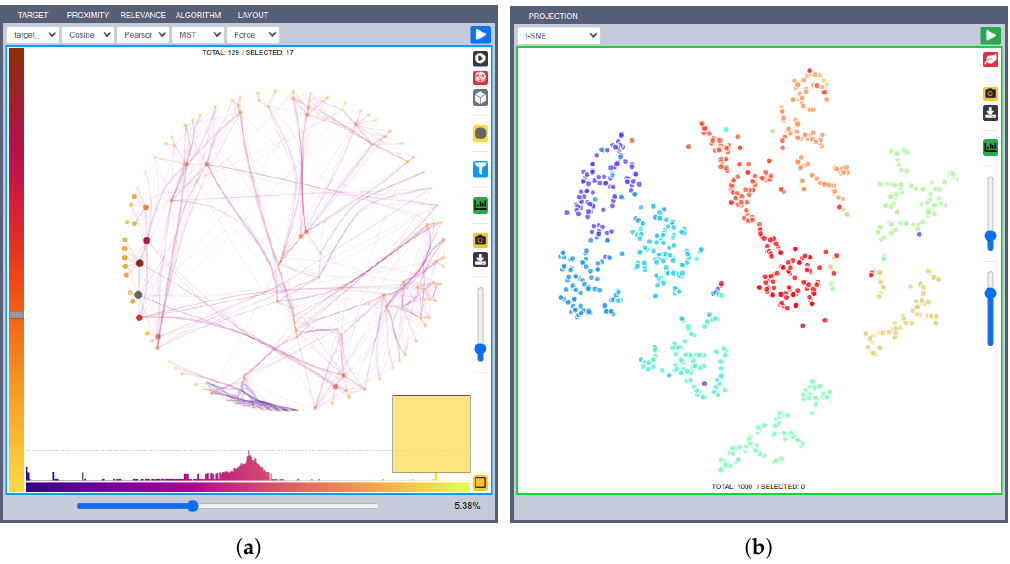
Figure 2. GFF main window and its two panels. The left panel ( a ) exhibits a minimum spanning tree for a dataset with 129 features. At the top the display construction parameters may be selected. The bar at the left enables selecting features by relevance. The slider at the bottom controls the inclusion of graph edges by increasing weight. Above the slider, the edge histogram allows a finer inclusion of graph edges by weight. The right buttons control force-directed placement, filtering, node transparency and visualization of selected features, among other features. The right panel ( b ) shows a projection of all data instances by using the selected features, with tool controls to the